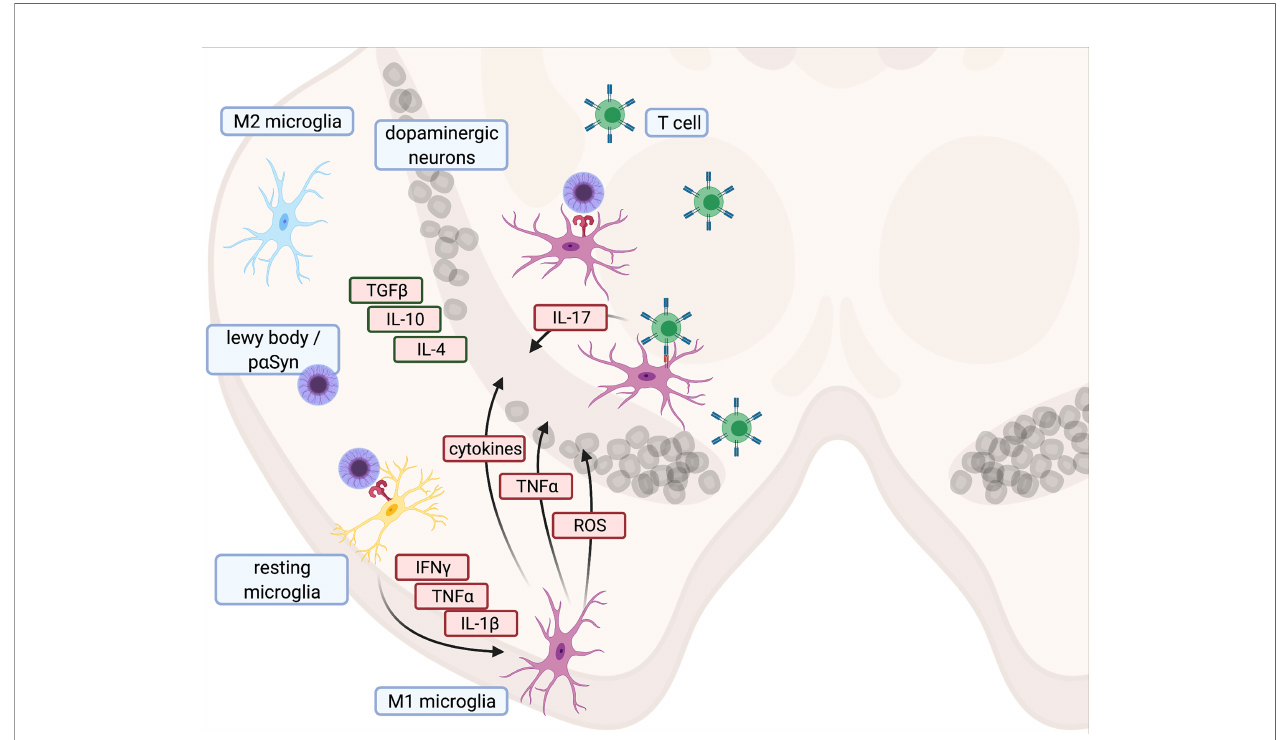
FIGURE 1 | Illustration of proin fl ammatory cascade and main cytokines contributing to cell death in Parkinson ’ s disease - Created with